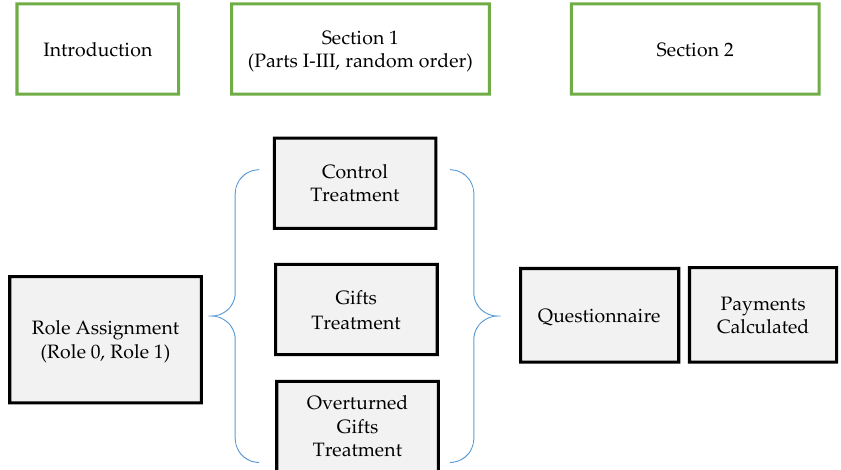
Figure 2. Overview of experimental